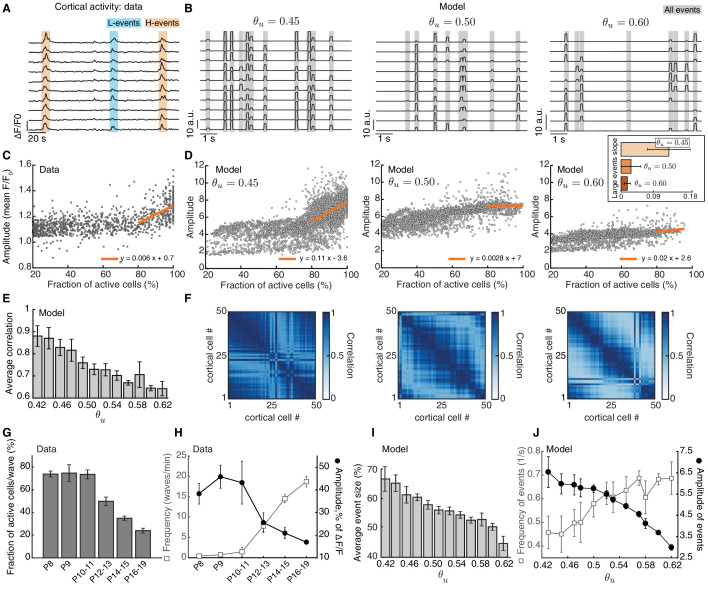
Adaptive H-events promote sparsification of cortical activity during development.(A) Spontaneous activity in the mouse visual cortex recorded in vivo at P8-10 (Siegel et al., 2012). Each activity trace represents an individual cortical cell. Blue and orange shading denotes L-events and H-events, respectively, as identified by Siegel et al., 2012. (B) Sample traces of cortical activity for different values of θu (as a proxy for developmental age). Gray shading denotes all events detected in our networks. (C) Amplitude vs. participation rate plot from the data (Siegel et al., 2012). The regression line for the amplitude vs. participation rate in H-events has a positive slope. (D) Amplitude vs. participation rate plots from the model, for different values of θu. Inset: The regression line for the amplitude vs. participation rate in large events with greater than 80% participation rate has a slope that decreases with θu. Error bars represent standard deviation. (E) Correlation between cortical neurons decreases as a function of the input threshold θu in the model, a proxy for developmental time. (F) Correlation matrices of simulated cortical neuron activity corresponding to D. (G,H). Event sizes and the relationship between frequencies (open squares) and amplitudes (filled circles) of spontaneous events at different postnatal ages (data reproduced from Rochefort et al., 2009). Error bars represent standard error of the mean (number of animals used at each age is provided in the original reference). (I) Spontaneous event sizes as a function of the input threshold θu. (J) Frequencies (squares) and amplitudes (circles) of events with 20–80% participation rate in the model at different input thresholds. Error bars represent the standard error of the mean of 10 simulations.